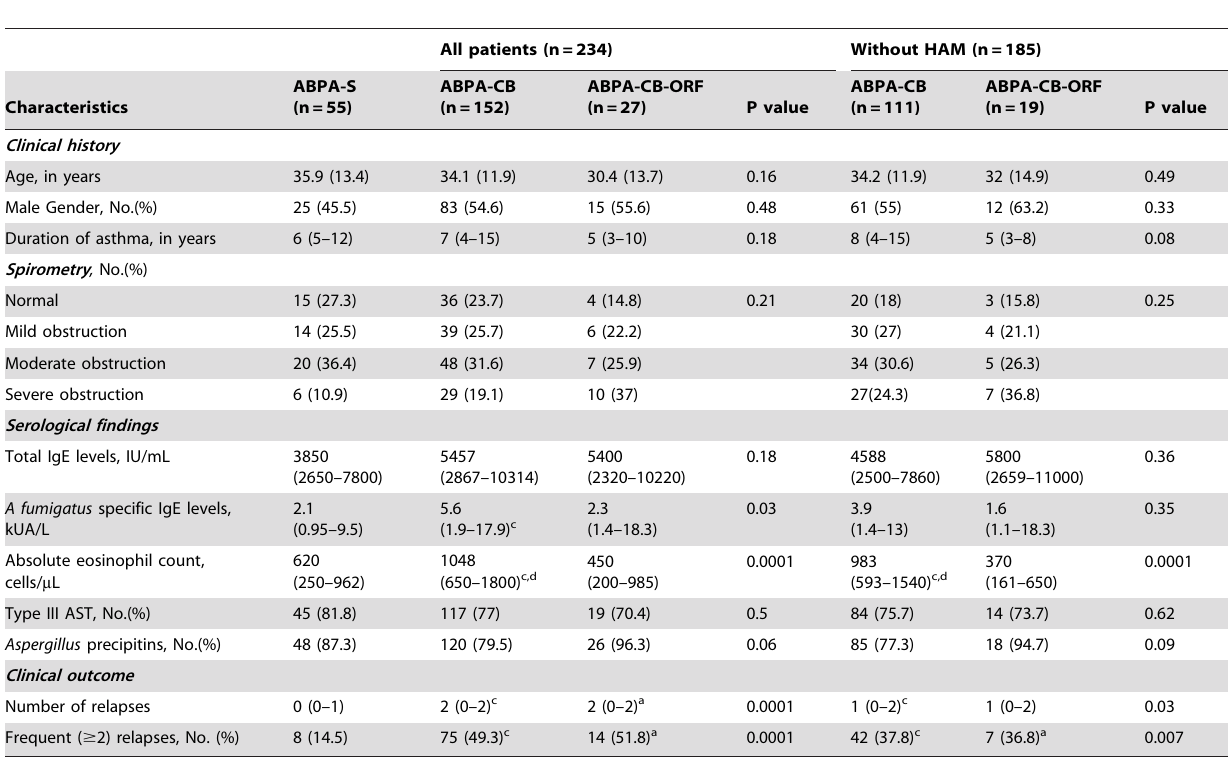
Table 3. Clinical, spirometric, serological differences and outcomes in patients with allergic bronchopulmonary aspergillosis (ABPA) based on the classification by Kumar et al with and without the presence high attenuation mucus (HAM).